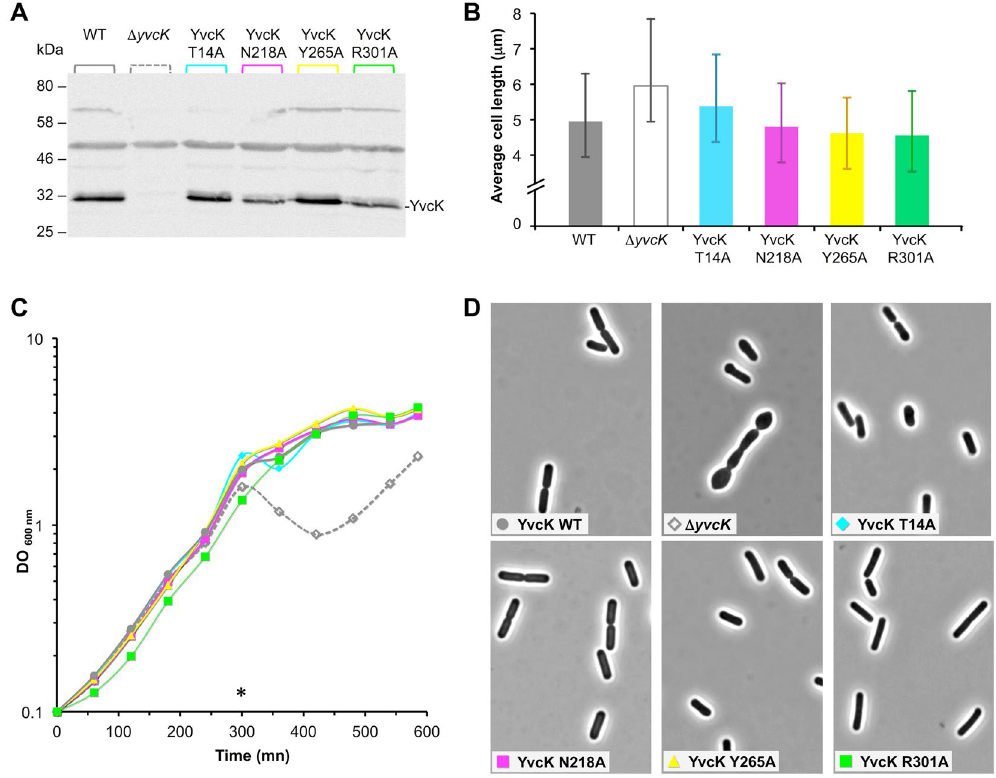
Figure 5. Mutations of residues interacting with UDP-sugars do not affect cell length and bacterial growth on minimal medium containing gluconate as sole carbon source. ( A ) Analysis of YvcK production by Western blotting. WT strain (168), Δ yvcK strain (SG471) and strains producing YvcK-T14A (SG520), YvcK-N218A (SG521), YvcK-Y265A (SG522) and YvcK-R301A (SG523) were grown at 37 °C in 20 ml of LB medium and collected at OD 600 = 1. 16 μ l of cell extracts were run on a 12.5% SDS-PAGE and transferred to nitrocellulose membrane by electroblotting. The blot membrane was read by the LAS4000 mini Imager. Full-length blot is presented in Supplementary data. ( B ) Bar graph of cell length averages for WT strain (168), Δ yvcK strain (SG471) and strains producing YvcK-T14A (SG520), YvcK-N218A (SG521), YvcK-Y265A (SG522) and YvcK- R301A (SG523). Bacteria were grown on LB medium until OD 600 = 0.4 and analyzed by microscopy. The data were obtained from four independent experiments and the standard deviations are representated by the error bars. ( C ) Effect of yvcK point mutations on B. subtilis growth on gluconate as sole carbon source. WT strain (168; grey circle), Δ yvcK strain (SG471 ; empty grey diamond) and strains producing YvcK-T14A (SG520; cyan diamond), YvcK-N218A (SG521; pink square), YvcK-Y265A (SG522; yellow triangle) and YvcK- R301A (SG523; green square) were grown overnight on LB medium with 1% glucose. After centrifugation, cells were grown in CE-gluconate liquid medium at 37 °C supplemented with 0.5% xylose. ( D ) Effect of yvcK point mutations on cell morphology during growth on gluconate as sole carbon source. Cells were grown in minimal medium supplemented with gluconate at 37 °C and collected after 300 mn of growth. Their morphology was analyzed by microscopy: see micrographs of WT strain (168; grey circle), Δ yvcK strain (SG471 ; empty grey diamond) and strains producing YvcK-T14A (SG520; cyan diamond), YvcK-N218A (SG521; pink square), YvcK-Y265A (SG522; yellow triangle) and YvcK-R301A (SG523; green